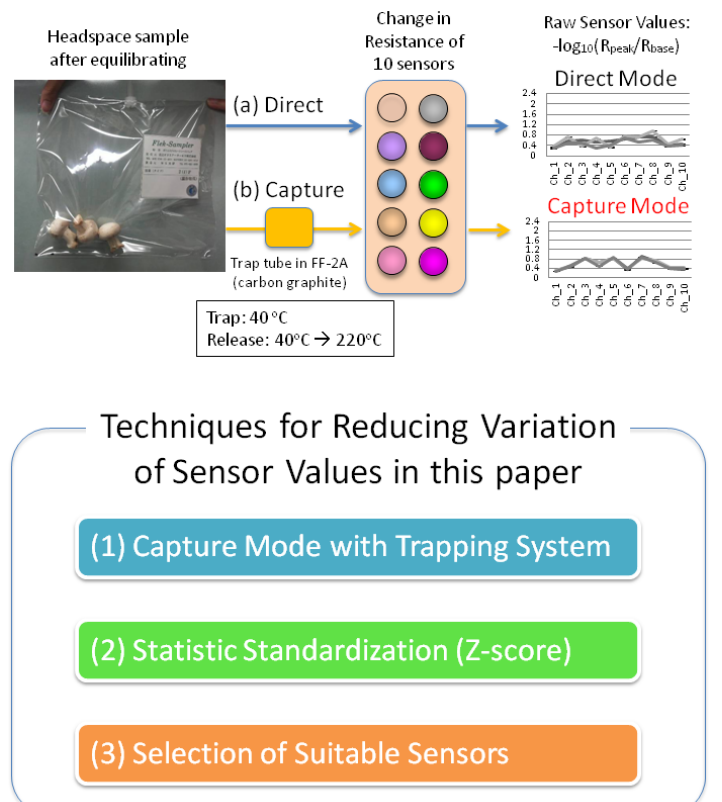
Figure 2. The measurement and analysis method